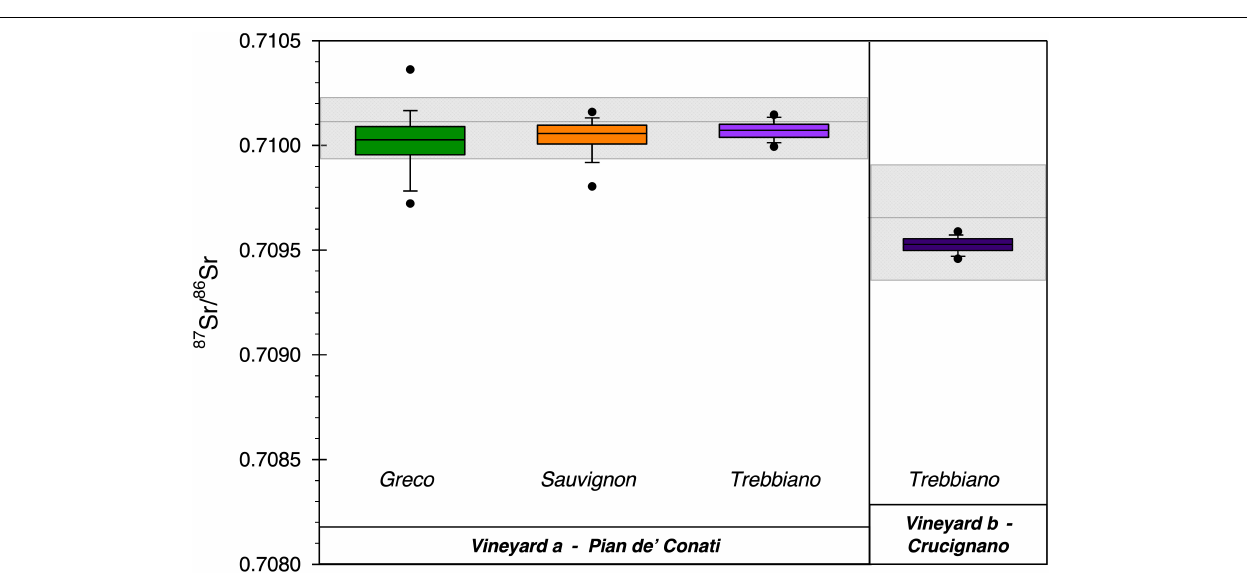
FIGURE 3 | 87 Sr/ 86 Sr values in grape samples from the different varieties grown on the two different vineyards, which are characterized by distinct geological backgrounds (see more details through the text). The Pian de’ Conati area (vineyard a ) is the place where the Greco, Sauvignon and, to minor extent Trebbiano cultivar, are grown. The area of Crucignano (vineyard b ) is committed to Trebbiano cultivar. The box plot features are reported through text and in the caption of Figure 2 . The gray pattern represents the whole range of variability of the bio-available fraction extracted from the soil of the two respective areas, the solid line represents the mean